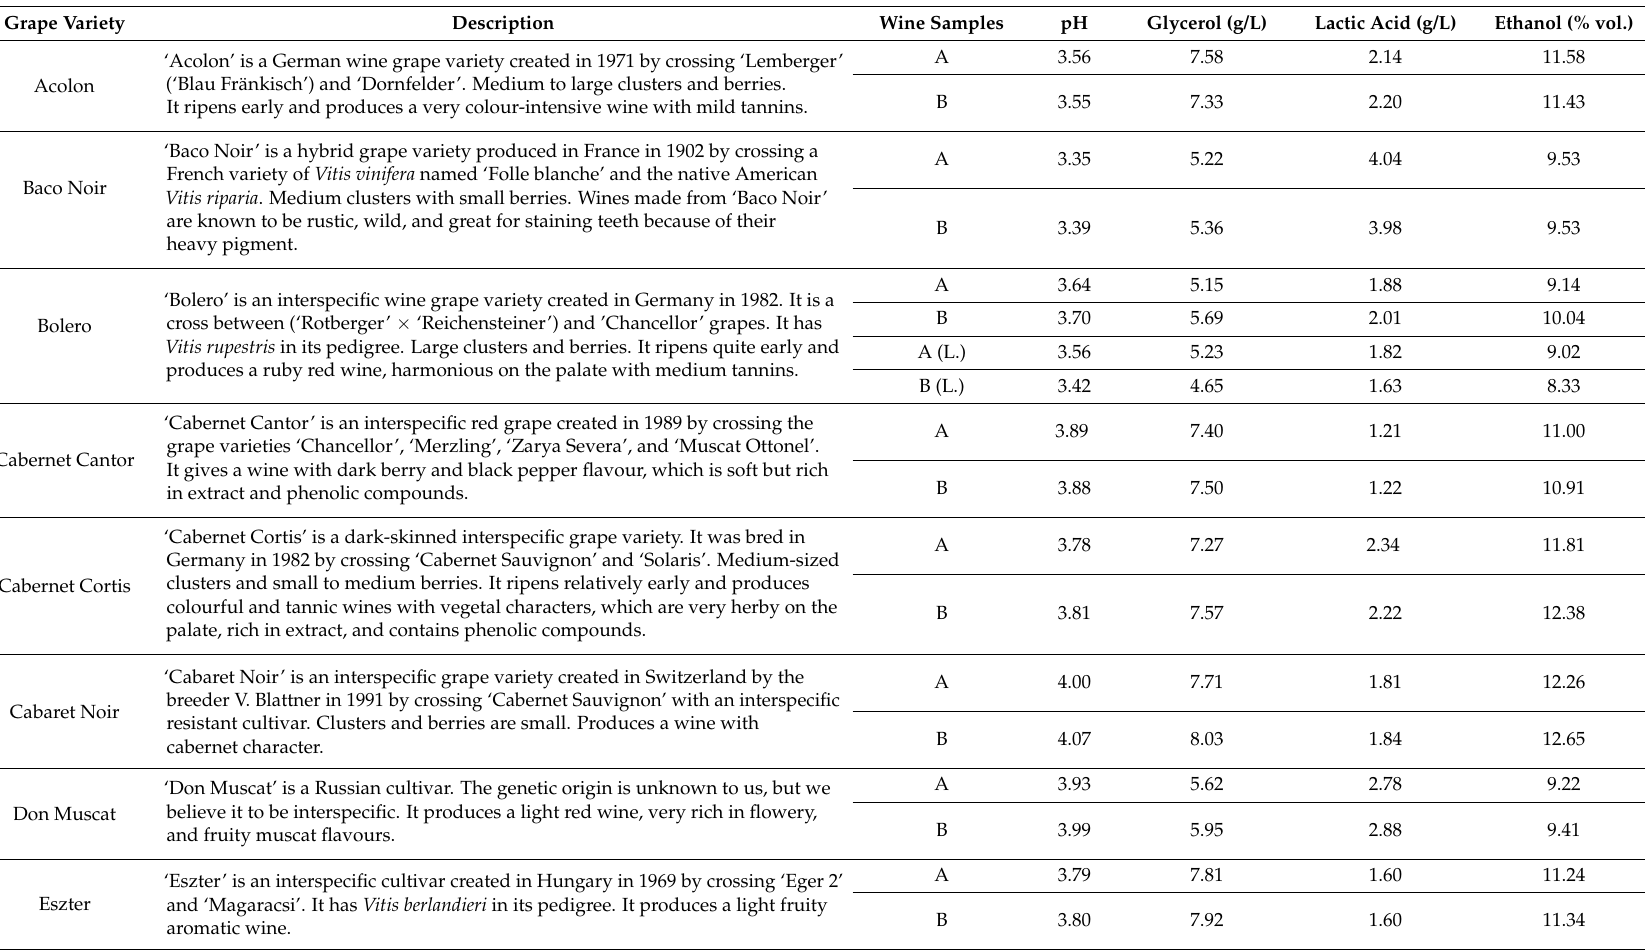
Table 2. List of the grape varieties used for making the wine samples. A and B represent different fermentation replicates. A brief description of the grape varieties, pH values, and the absolute concentrations of glycerol, lactic acid, and ethanol, as measured by the WineScan instrument in the wine samples, are reported. Absolute concentrations are expressed as g/L or % volume (ethanol). (L.): Grapes form plants treated with LalVigne Mature at veraison; (Y.): Grapes from young